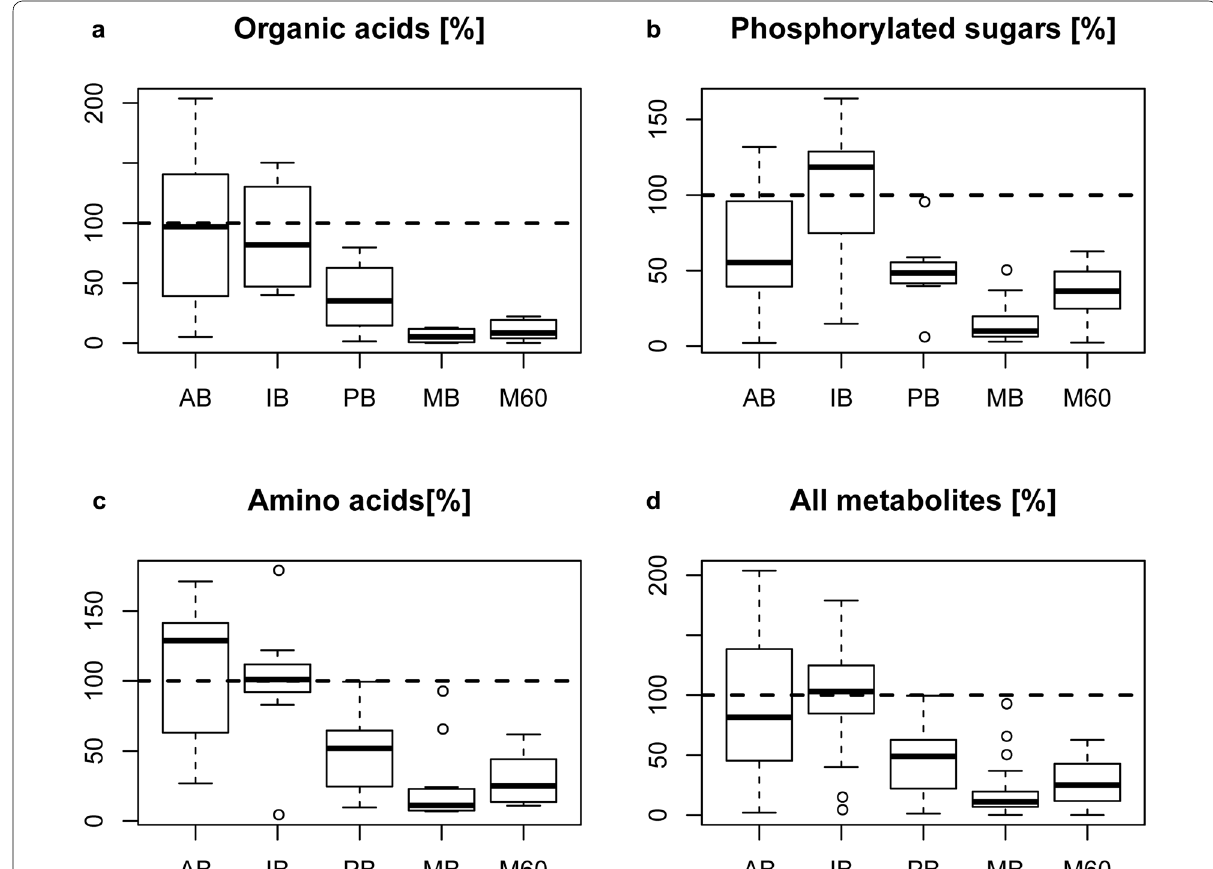
Fig. 4 Box plots of recovery ratios IC/(TB EC) 100%. IC intracellular, TB total broth and EC extracellular for AceB, IsoaB, ProB, MethB, and = − × Meth60. AceB: acetone; IsoaB: isoamylol; ProB: propanol; MethB: methanol with base solution 5:1 (v/v) at 30 °C, respectively; Meth60: 60% − methanol at 30 °C. Base solution consisted of acetone: ethanol 1:1 (mol/mol). Box plots indicated the median, as well as the first and third − = quartiles. The whiskers indicate the most extreme point from the first and third quartiles within 1.5 times of the distance between the first and third quartiles; points at a greater distance are indicated by circles. The four sections show the results of organic acids ( a left-top), phosphorylated sugars ( b right-top), amino acids ( c left-bottom), and of all metabolites ( d